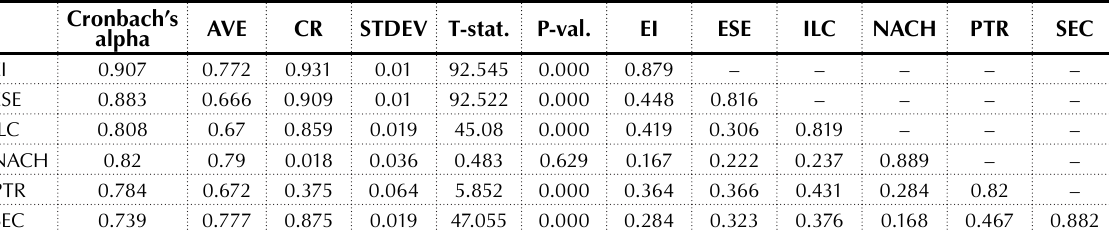
Table 4. Summary reliability and validity